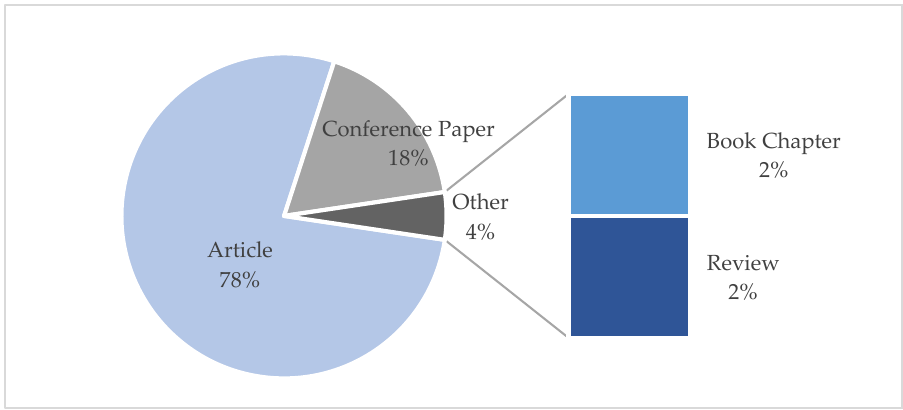
Figure 6. Categorization based on document types .